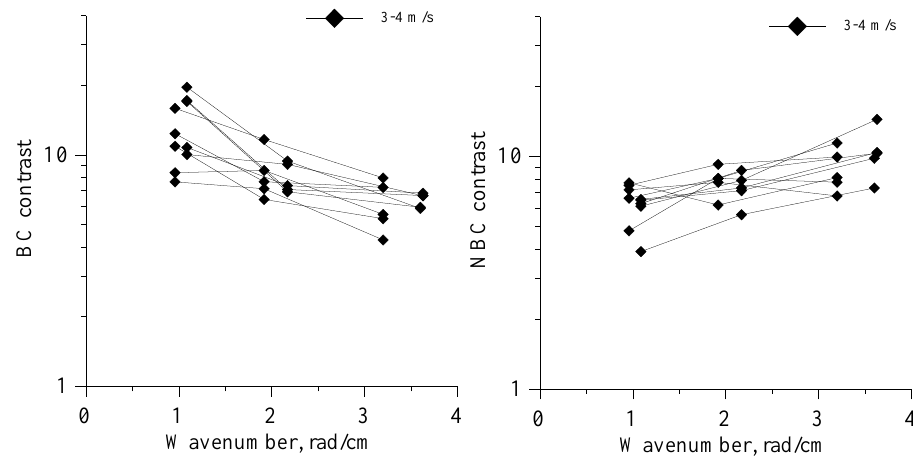
Figure 6. BC and NBC cross wind contrasts vs. Bragg wave number. The Black Sea, wind velocity of 3 – 4 m/s, incidence angles of 50° and 60°.